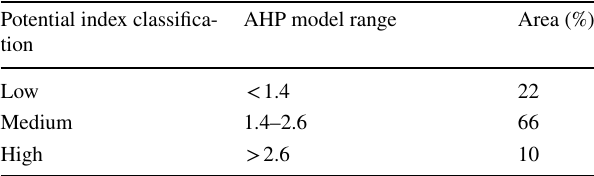
Table 3 Characteristics of the groundwater potential map based